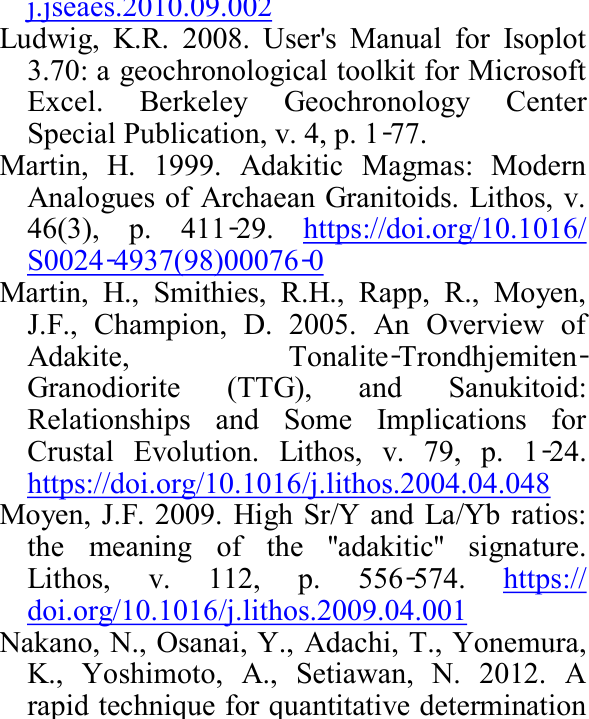
3.70: a geochronological toolkit for